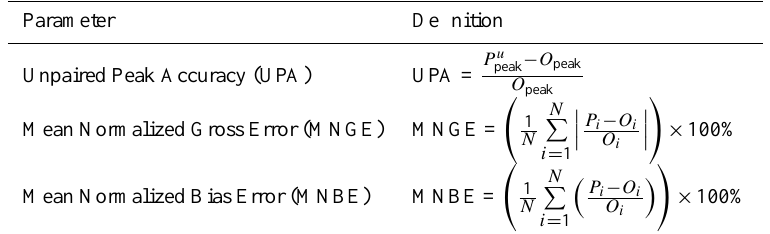
Table 1. Definition of US EPA recommended statistic parameters: UPA, MNGE and MNBE. Parameter Definition